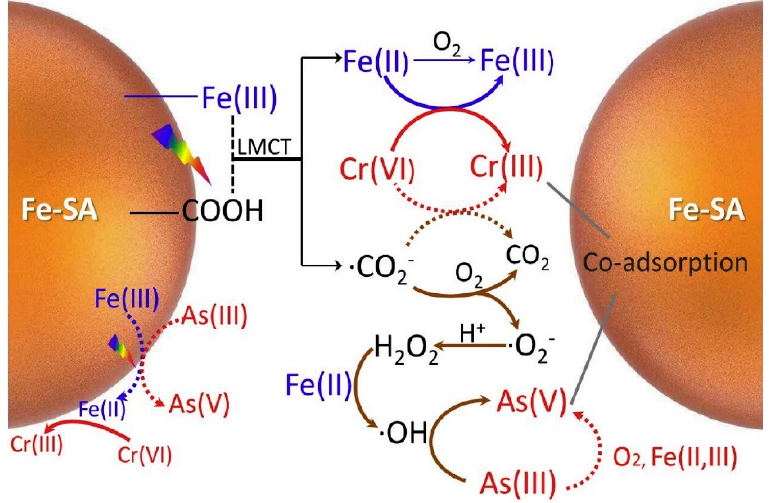
Figure 4. Schematic diagram of photocatalytic simultaneous conversion of Cr(VI) and As(III). (LMCT—ligand to metal charge transfer) (Adapted from [61]).